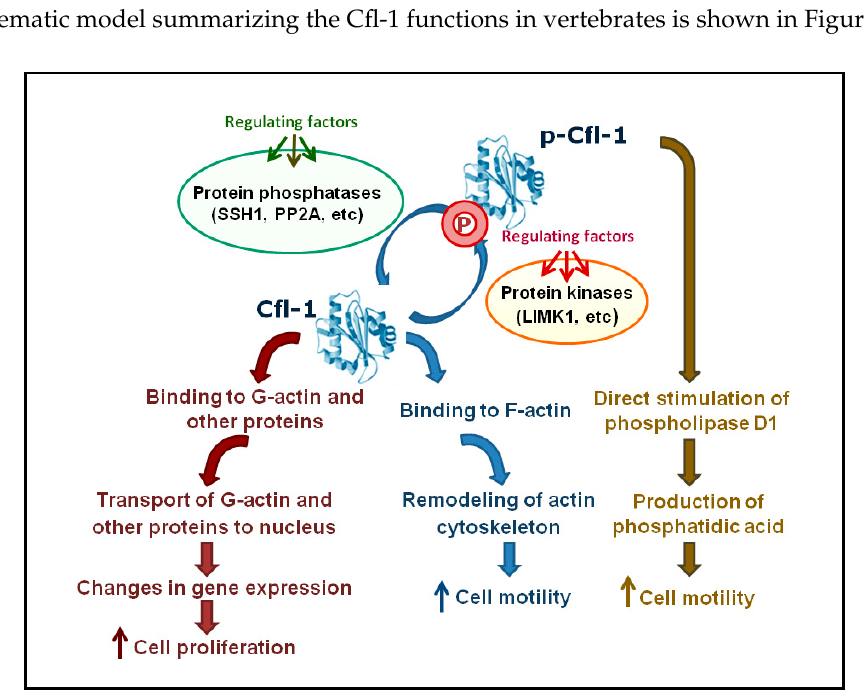
Figure 3. Schematic model summarizing Cfl-1 functions in vertebrates. Regulating factors (green) and regulating factors (red) refer to different signaling pathways, leading to Cfl-1 dephosphorylation (activation) or phosphorylation (inactivation), respectively. p-Cfl-1: phospho-Cfl-1; SSH1: Slingshot protein phosphatase 1; PP2A: Protein phosphatase 2A; LIMK1: LIM domain kinase 1.